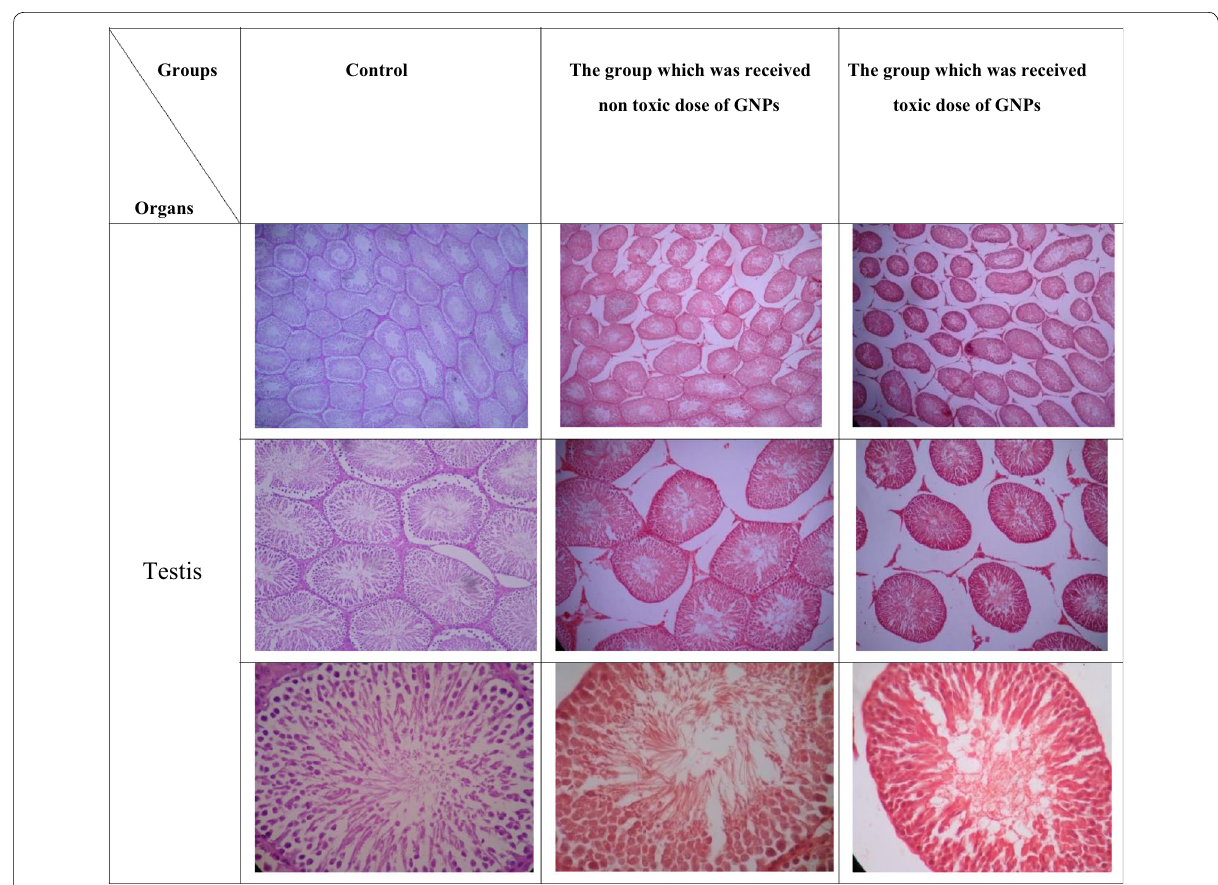
Fig. 7 The results of injection of non-toxic and toxic doses of GNPs on the testis histology in contrast to the control group. The magnification in the first row for each organ is 40, the second represented 100 and the third represented 400 (H&E × × ×